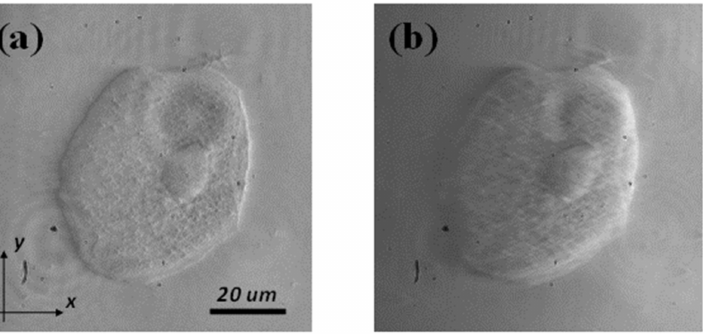
Figure 10. Chromatic aberrations of the objective lens. ( a ) Sample is in focus at green illuminations, whereas in ( b ) we see that at blue illumination the sample is out of focus due to the